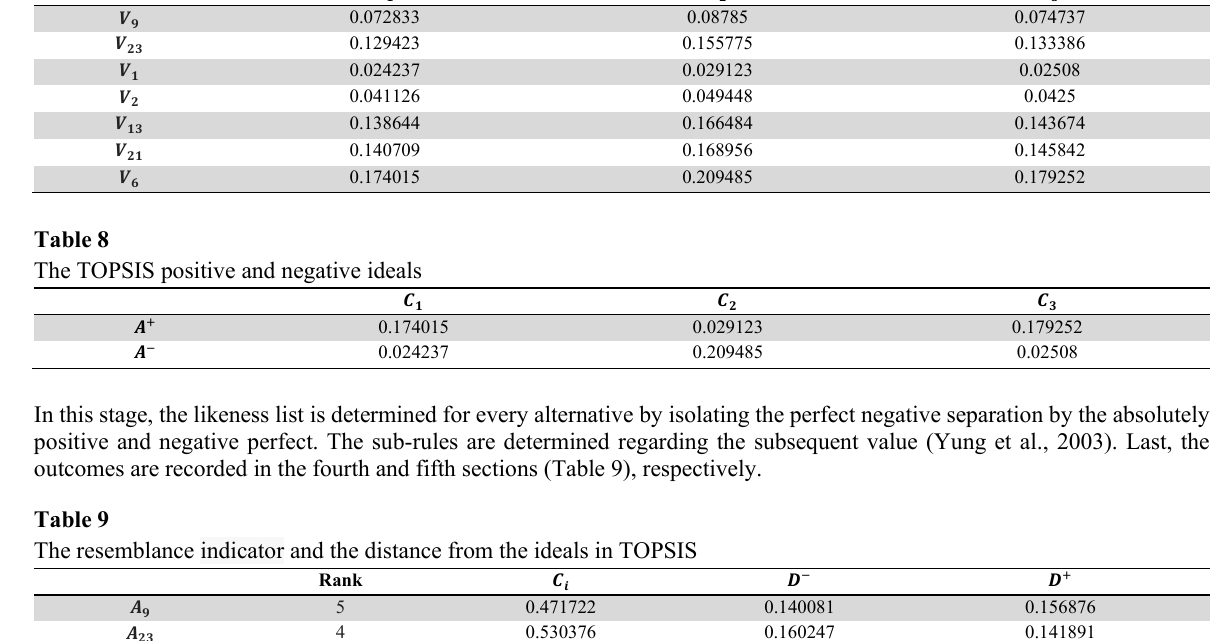
The resemblance indicator and the distance from the ideals in TOPSIS Rank 𝑪 𝒊